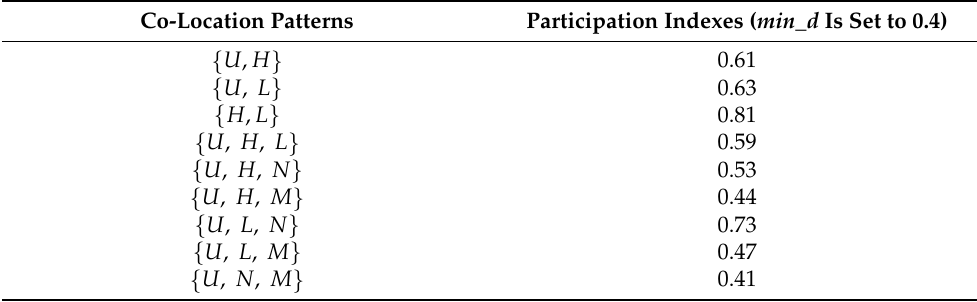
Table 3. The participation indexes of co-location patterns.